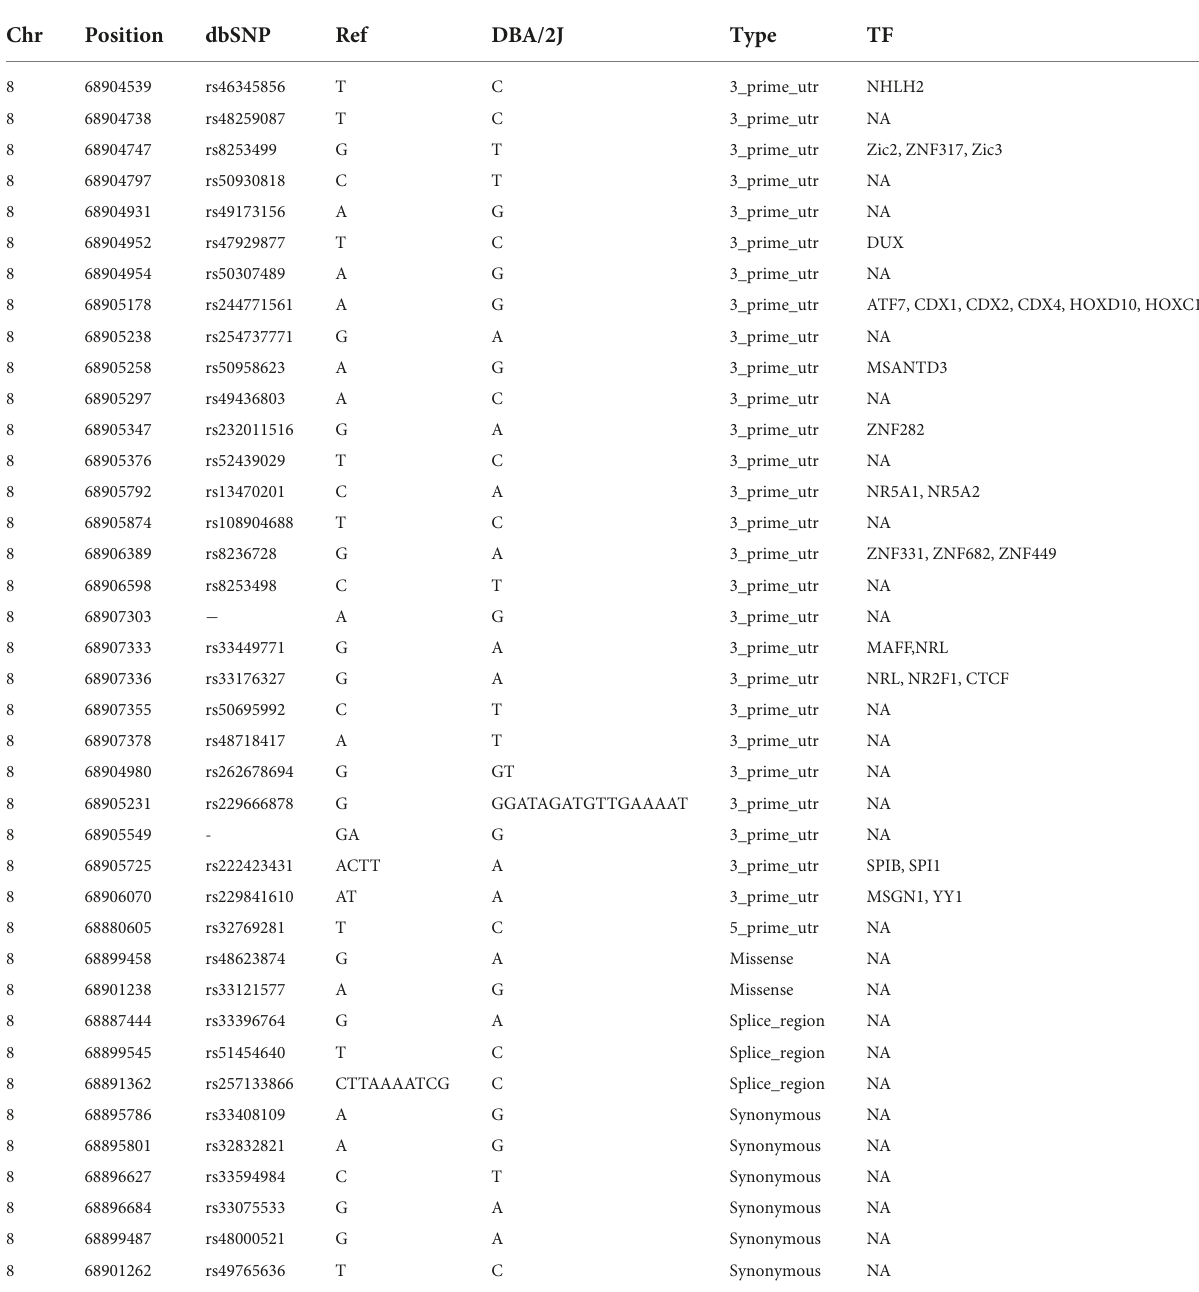
TABLE 2 Lists of Lpl genetic variants between B6 and